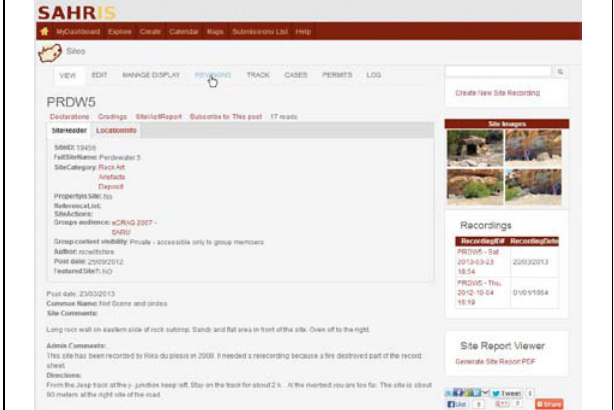
Figure 4. A rock art site with images and recent and historical site